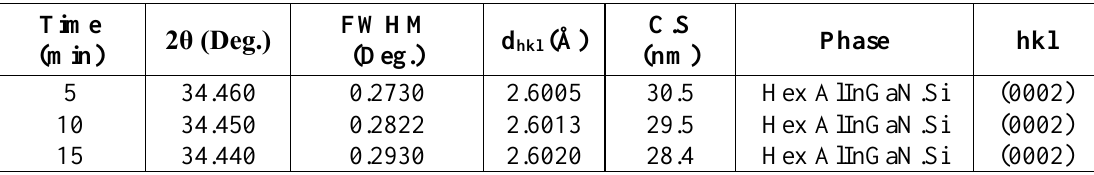
Table 1: FWHM, miller indices, phase and grain size of the porous quaternary AlInGaN thin films grown on Si